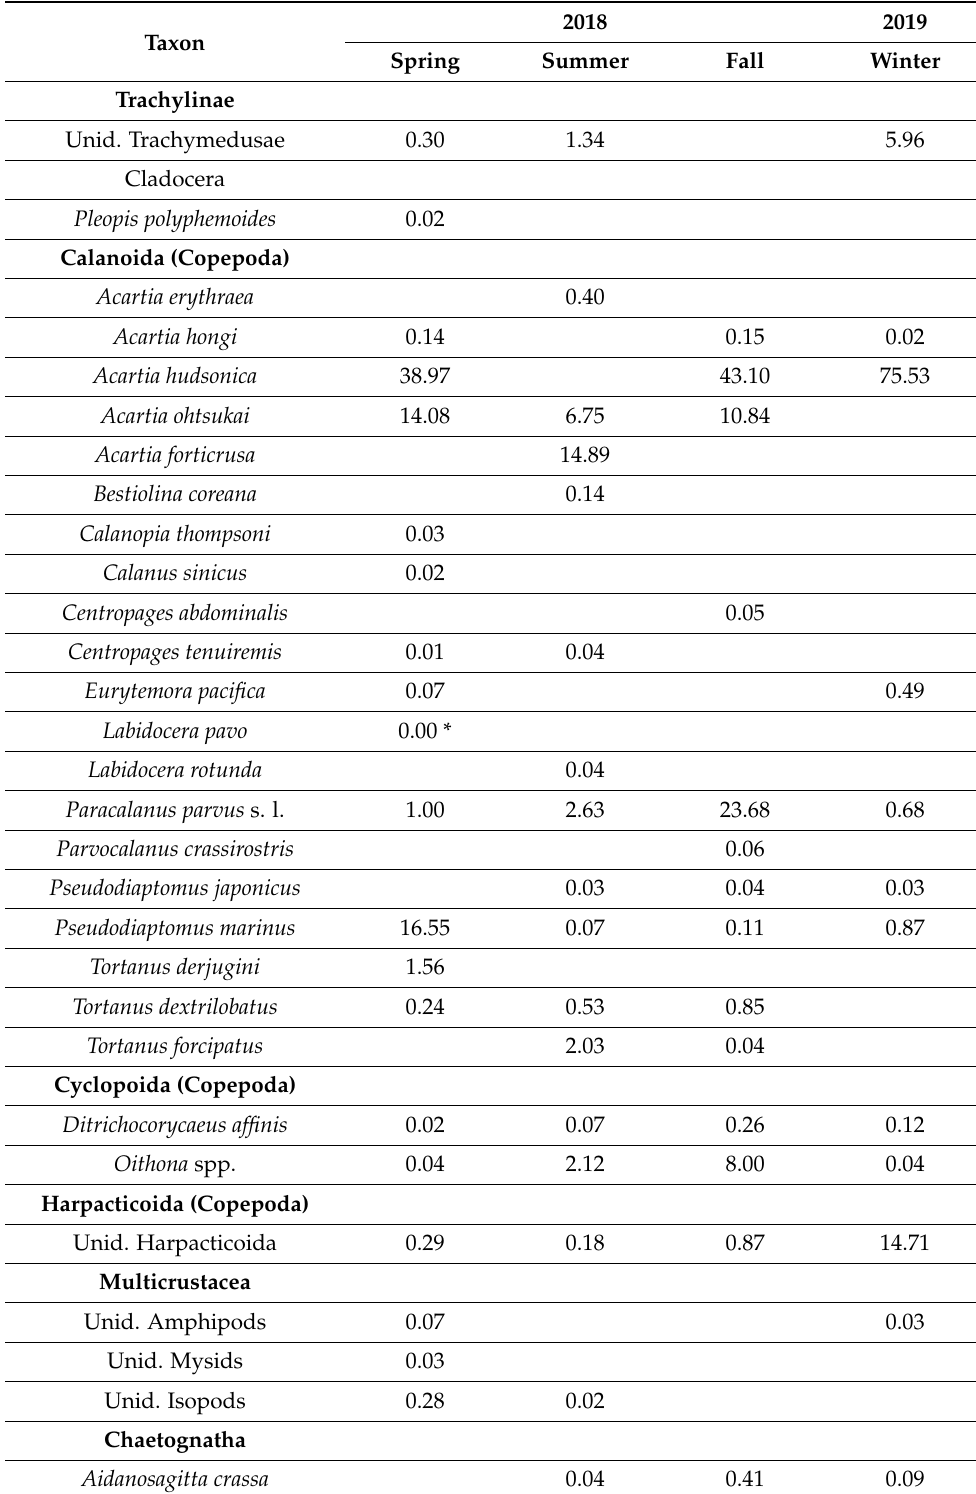
Table 1. List of the zooplankton living in Doam Bay and their contribution (%) during the study period. In the last two rows of the table, the numbers following the ± mark indicate the standard deviation of the population mean. The asterisks indicate that the contribution rate of a particular taxon is lower than 0.1% but greater than 0. Abbreviation: Unid,